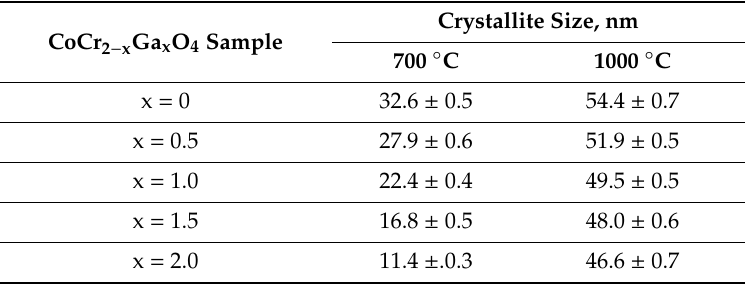
Figure 1. XRD patterns of CoCr 2 − x Ga x O 4 powders (x = 0–2) calcined at 700 ◦ C ( a ) and annealed at 1000 ◦ C ( b ). The estimated crystallite size of the CoCr 2 − x Ga x O 4 powders synthesized at di ff erent